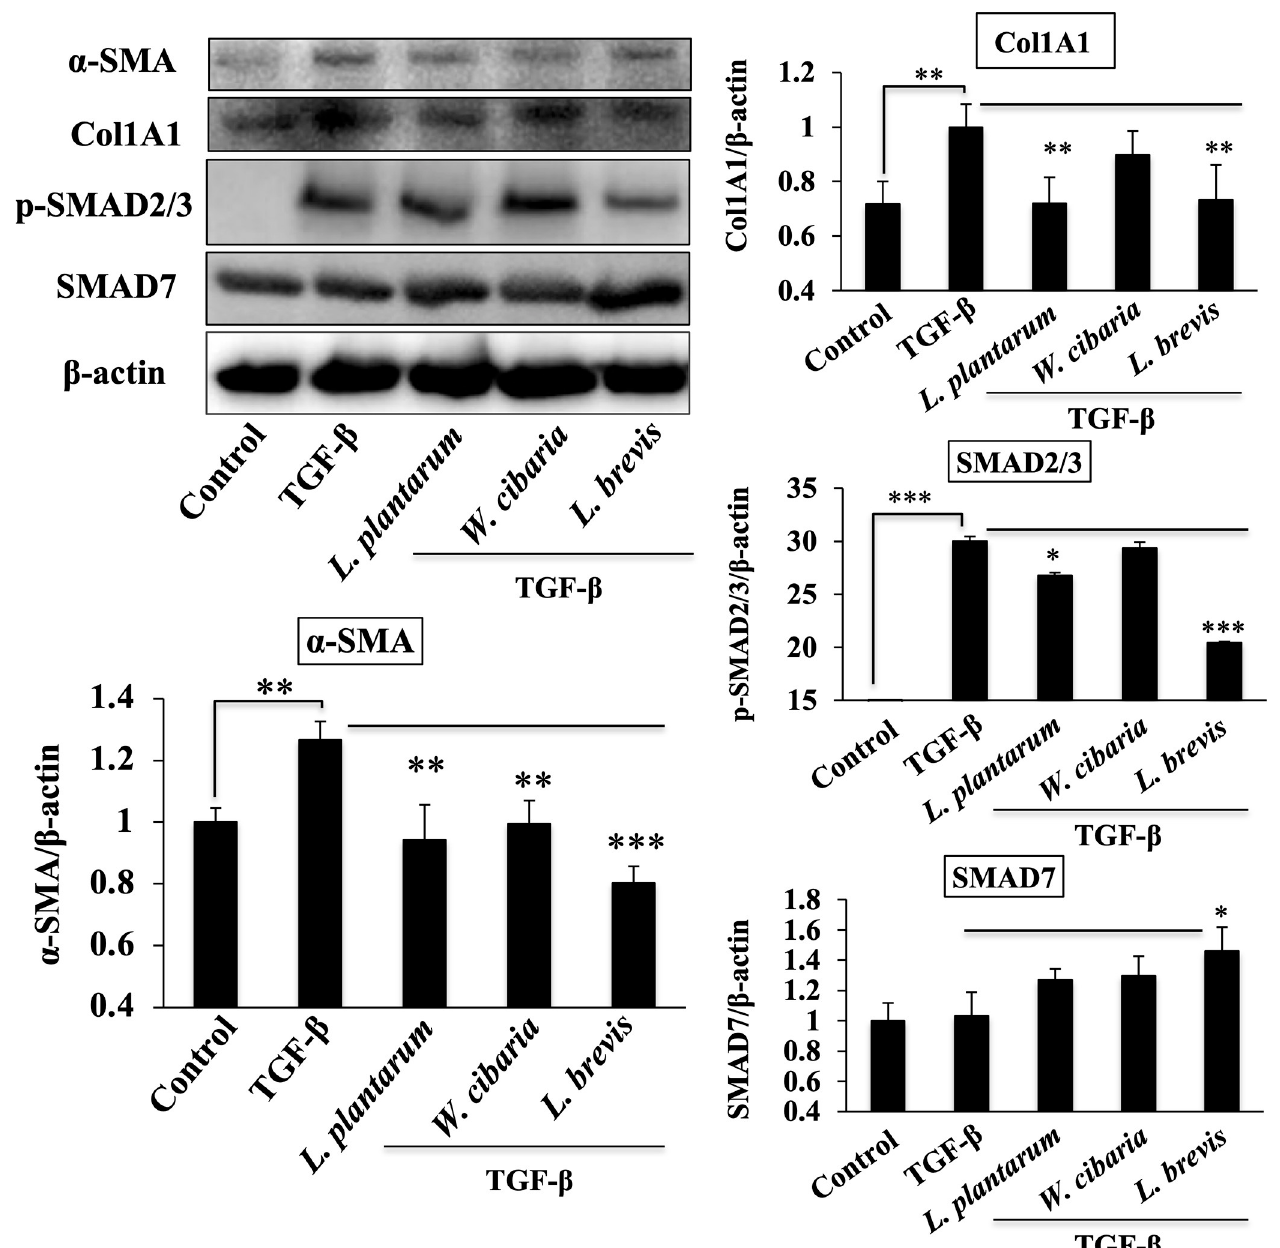
Fig 5. LAB strains modulate TGF- β induced fibrogenic markers and SMAD-dependent TGF- β signaling in LX-2 cells. Confluence LX-2 cells were treated with LABs for 48 h, and stimulated with TGF- β for 120 minutes. Western blot was performed to determine the level of α -SMA, Col1A1, p-SMAD2/3, and SMAD7 at the indicated time point. Image J software was used to determine the intensities of protein bands. The bar graphs are the average of two different experiments (mean + S.D). � p < 0.05, �� p < 0.01, ��� p < 0.001.